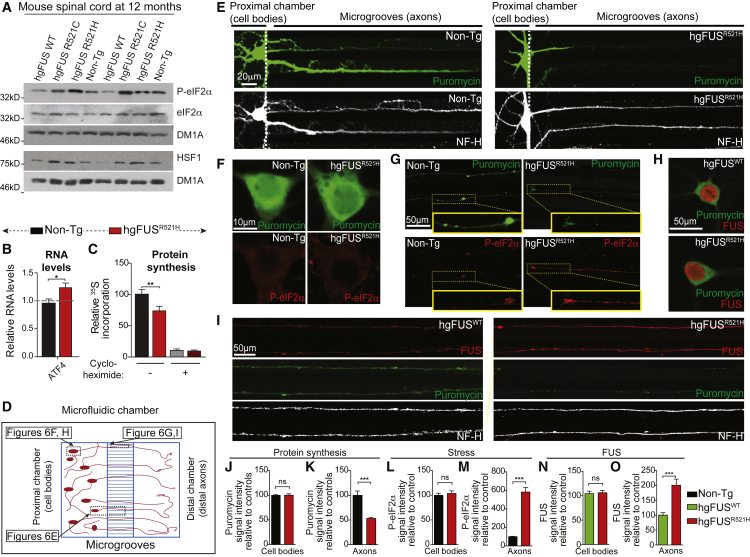
ALS-Linked Mutations in FUS Cause Stress-Mediated Reduction in Axonal Protein Synthesis(A) Immunoblot demonstrating increased stress mediated by mutant FUS at early symptom onset using the phosphorylated form of eIF2α antibody (P-eIF2α) and HSF1 antibody in 12-month-old hgFUSR521C and hgFUSR521H spinal cords compared to age-matched Non-Tg and hgFUSWT. eIF2α and tubulin antibodies were used as loading controls. See also quantification in Figures S6A and S6B.(B) Expression of Atf4 in primary hippocampal neuronal cultures from hgFUSR521H compared to Non-Tg mice. Data are represented as mean ± SEM (n ≥ 3 biological replicates per group). ∗p < 0.05, two-sided unpaired Student’s t test.(C) Quantification of the amount of 35S incorporated into newly translated proteins in hippocampal neurons cultured for 15 days. Cycloheximide (25 μg/mL) addition was used as a positive control for complete protein translation inhibition. Data are represented as mean ± SEM (n = 4 biological repeats). ∗∗p < 0.01, two-sided unpaired Student’s t test.(D) Schematic of the experimental design using microfluidic compartmented chambers to distinguish neuronal cell bodies from axons.(E–G) Hippocampal neurons isolated from hgFUSR521H or Non-Tg mice (from four independent experiments with 3 or 4 mouse embryos per genotype per experiment) cultured in compartmented chambers and treated with a 10-min pulse of puromycin to label protein translation sites using puromycin antibody (green) with a neurofilament NF-H (white) antibody to stain axons (E) or with an antibody recognizing the phosphorylated form of eIF2α (P-eIF2α) (red) in (F) cell bodies and (G) neuronal processes. Scale bars, 10 μm and 50 μm, respectively.(H and I) Hippocampal neurons isolated from hgFUSR521H and hgFUSWT mice cultured in compartmented chambers immunostained for FUS (using FUS antibody in red) and protein translation (using puromycin antibody in green) in (H) cell bodies and (I) axonal processes (using NF-H antibody, white). Scale bar, 50 μm.(J–M) Quantification of the puromycin relative fluorescence intensity (protein translation) in (J) cell bodies (green signal in Figure 6F) and (K) axons (green signal in Figure 6G); quantification of P-eiF2α fluorescence intensity (stress) in (L) cell bodies (red signal in Figure 6F) and (M) axons (red signal in Figure 6G) of Non-Tg and hgFUSR521H hippocampal neurons cultured in microfluidic chambers. The bar graph represents mean ± SEM (n ≥ 30 axons or cell bodies per group from four independent experiments). ∗∗∗p < 0.001, two-sided unpaired Student’s t test.(N and O) Quantification of FUS relative fluorescence intensity in (N) cell bodies (red signal in Figure 6H) and (O) axons (red signal in Figure 6I). The bar graph represents mean ± SEM (n ≥ 50 axons or cell bodies per group). ∗∗∗p < 0.001, two-sided unpaired Student’s t test.